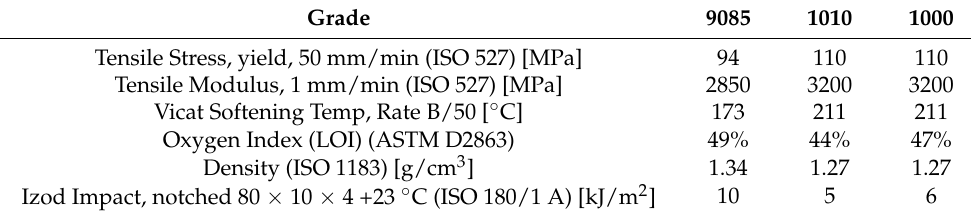
Table 1. ULTEM™ grades properties comparison [11–13].